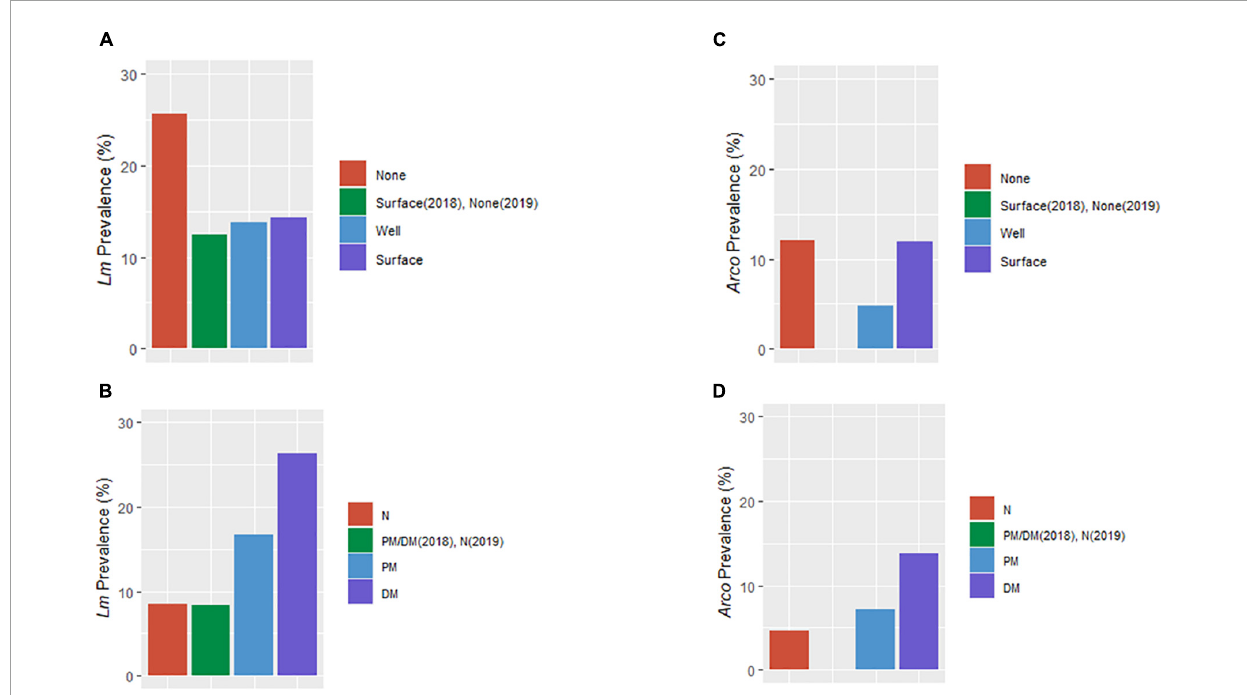
FIGURE9 Distribution of Lm and Arcobacter ( Arco ) prevalence in OH soil by irrigation source (A,C) and soil amendment (B,D) . BSA, biological soil amendment; BSAAO, biological soil amendments of animal origin; None, no irrigation of the field; Surface, irrigation performed with surface water; Well, irrigation via well water; N, not amended with BSA or BSAAO; PM, poultry manure; DM, dairy manure.